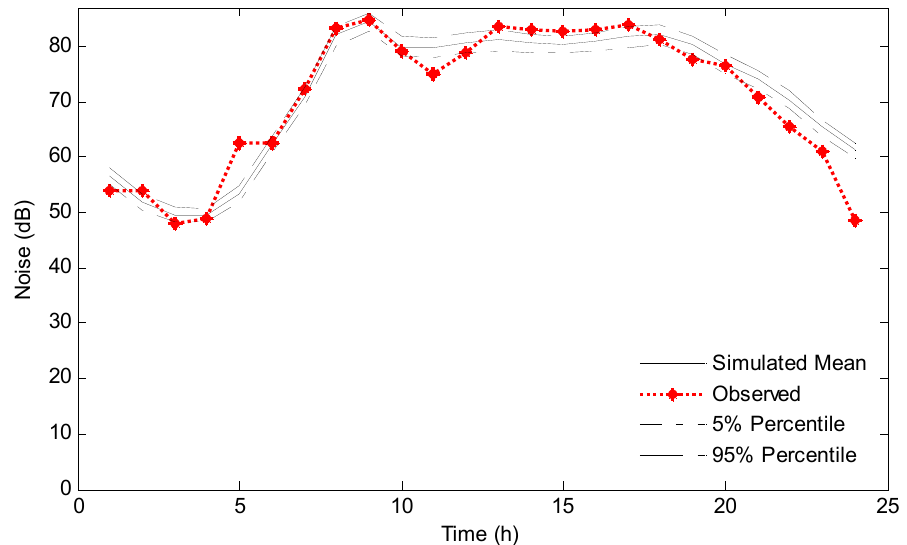
Figure 11. Variations of parameters ( a ) and ( b ) in Model (20) during the data assimilation process under scenario B.